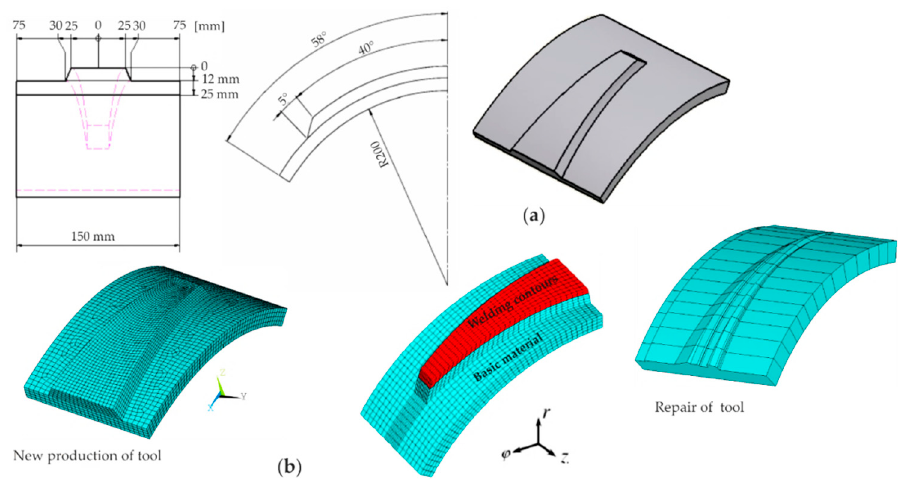
Figure 3. Geometry of the tool: ( a ) CAD (computer aided design) model, ( b ) FE model.